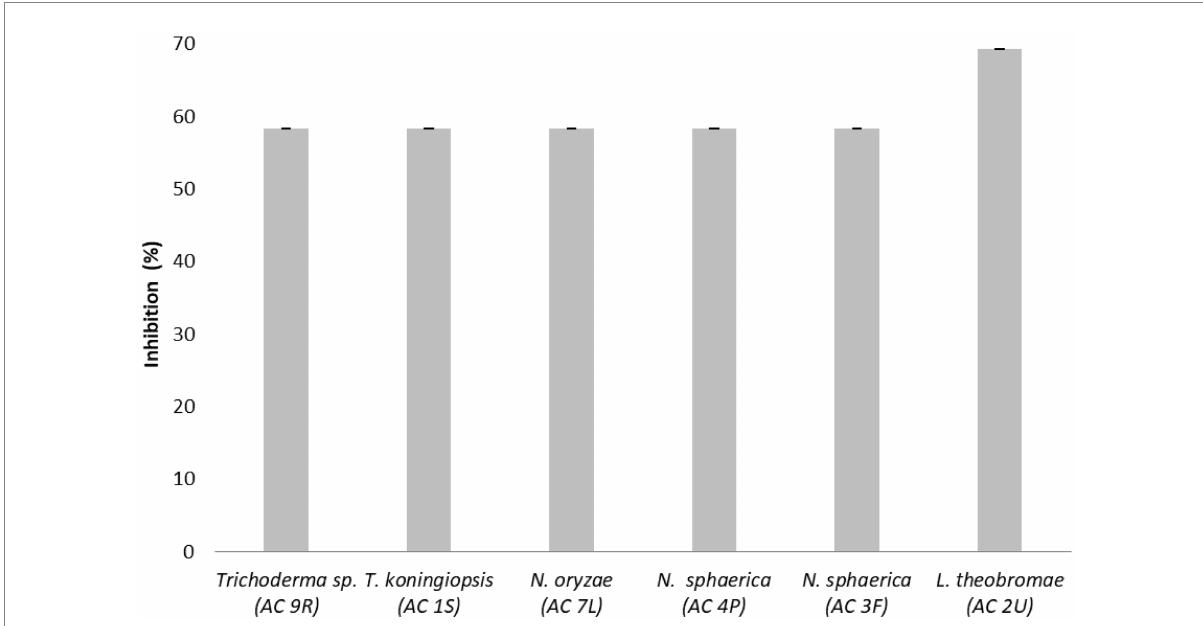
FIGURE 3 Inhibition percentages (I%) of endophytic fungi against the pathogen Ceratocystis fimbriata in dual culture assay. Data are mean ± standard error (SE) of triplicates.